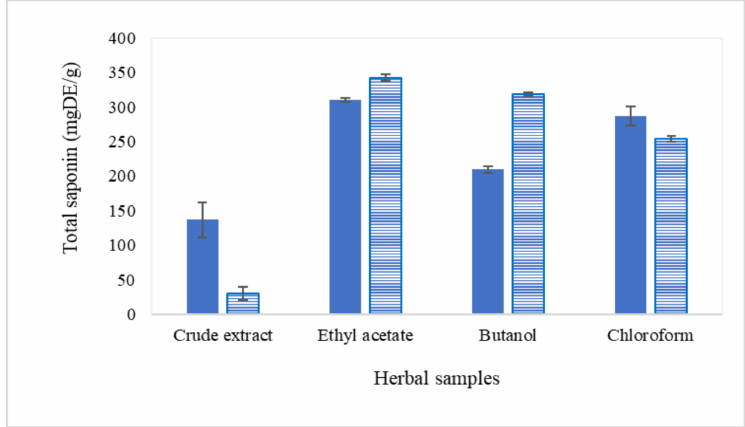
Figure 2. Total saponins of organic fractions (solid bar) and precipitates (line bar) expressed as mg DE/g in different solvent